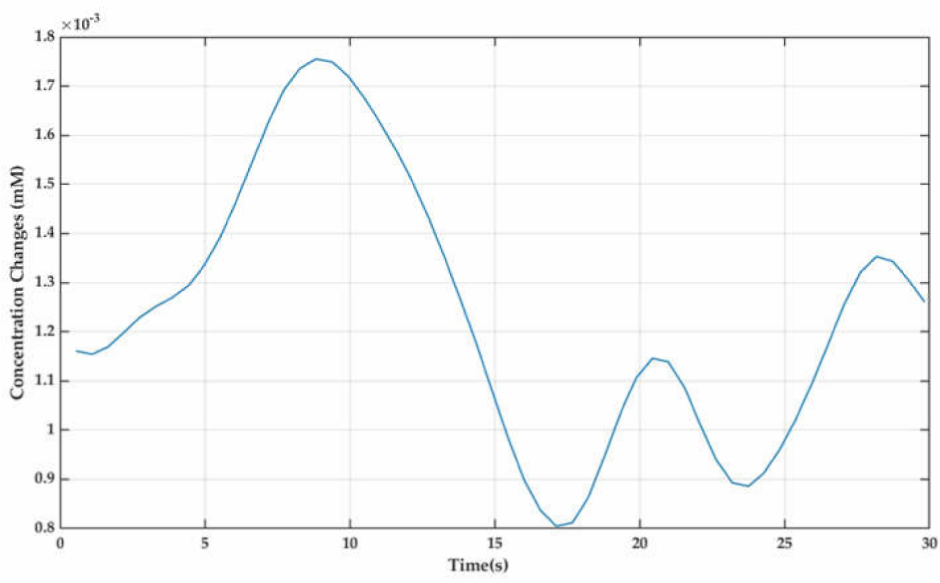
Figure 5. Averaged ∆ c HbO ( t ) signal for task and rest of subject